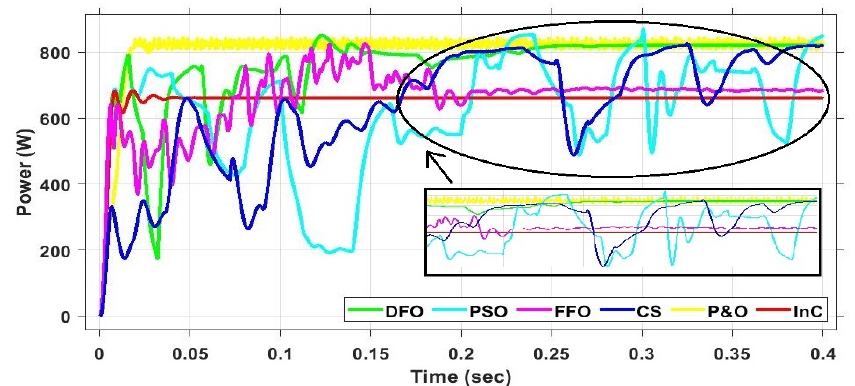
Figure 31. PS3 power comparison between all algorithms for MLPE Distributed PV system.